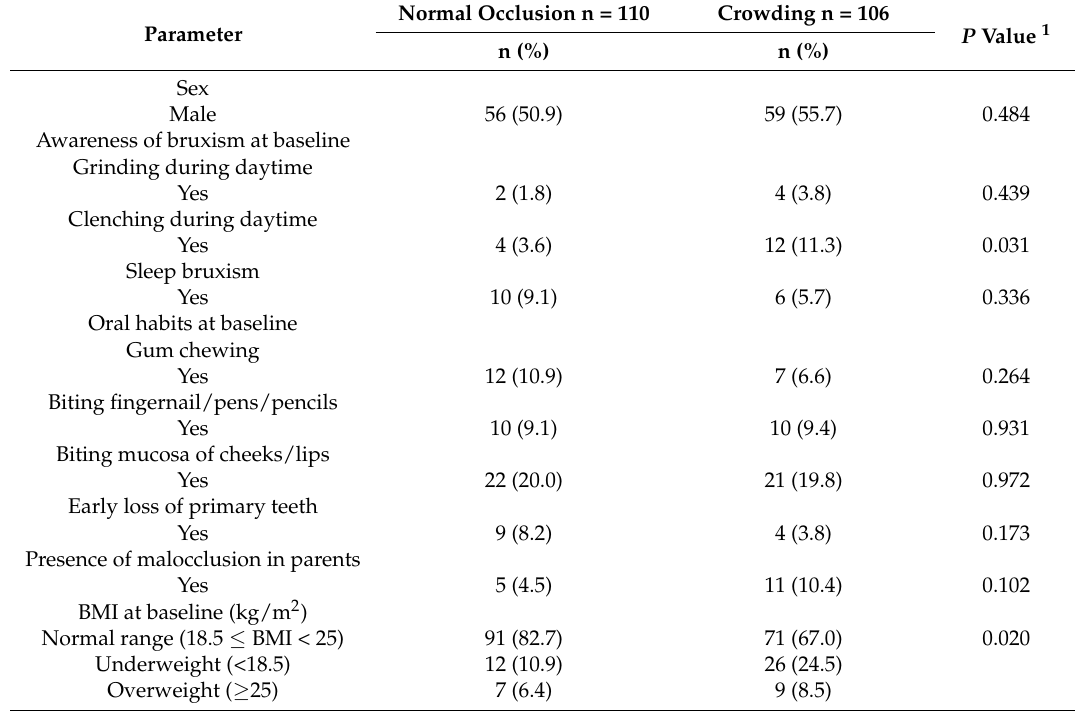
Table 4. Association between onset of crowding and other parameters among Okayama University students, Japan,